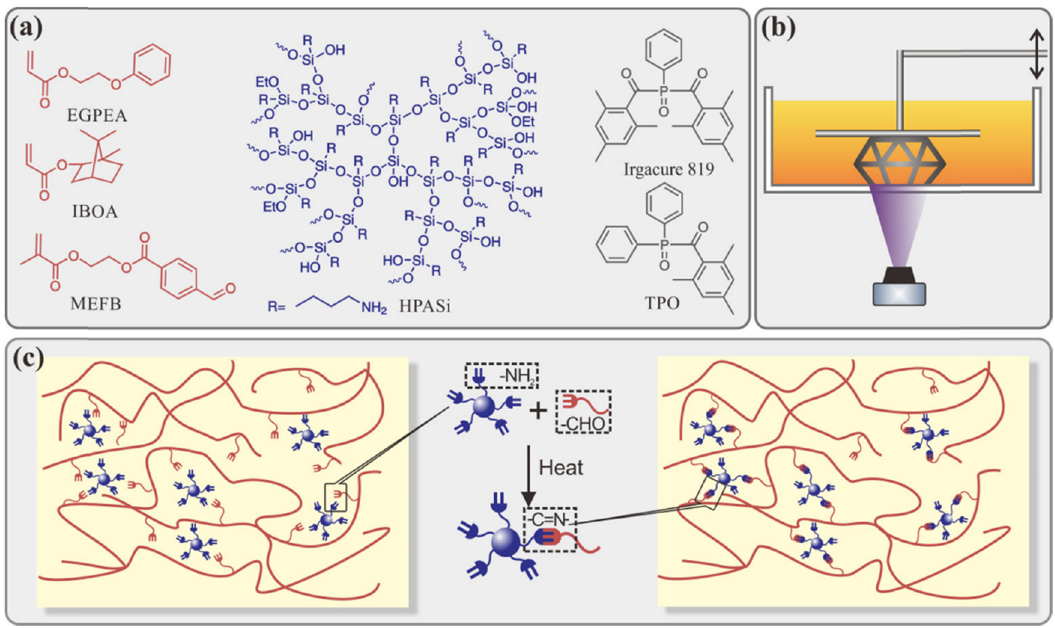
Figure 11: Schematic illustrations of the 4D - printing of shape memory polymer networks. ( a ) Chemical structures of ( meth ) acrylate monomers ( EGPEA, IBOA, and MEFB ) , cross - linker ( HPASi ) , and initiators ( Irgacure 819 and TPO ) in the photopolymer solution. ( b ) DLP 3D - printing system for printing of 3D structures. ( c ) Formation of dynamic imine bonds of cross - linked resins through the reaction of aldehyde groups and amino groups on HPASi. Copyright 2019, American Chemical Society ( 124 )